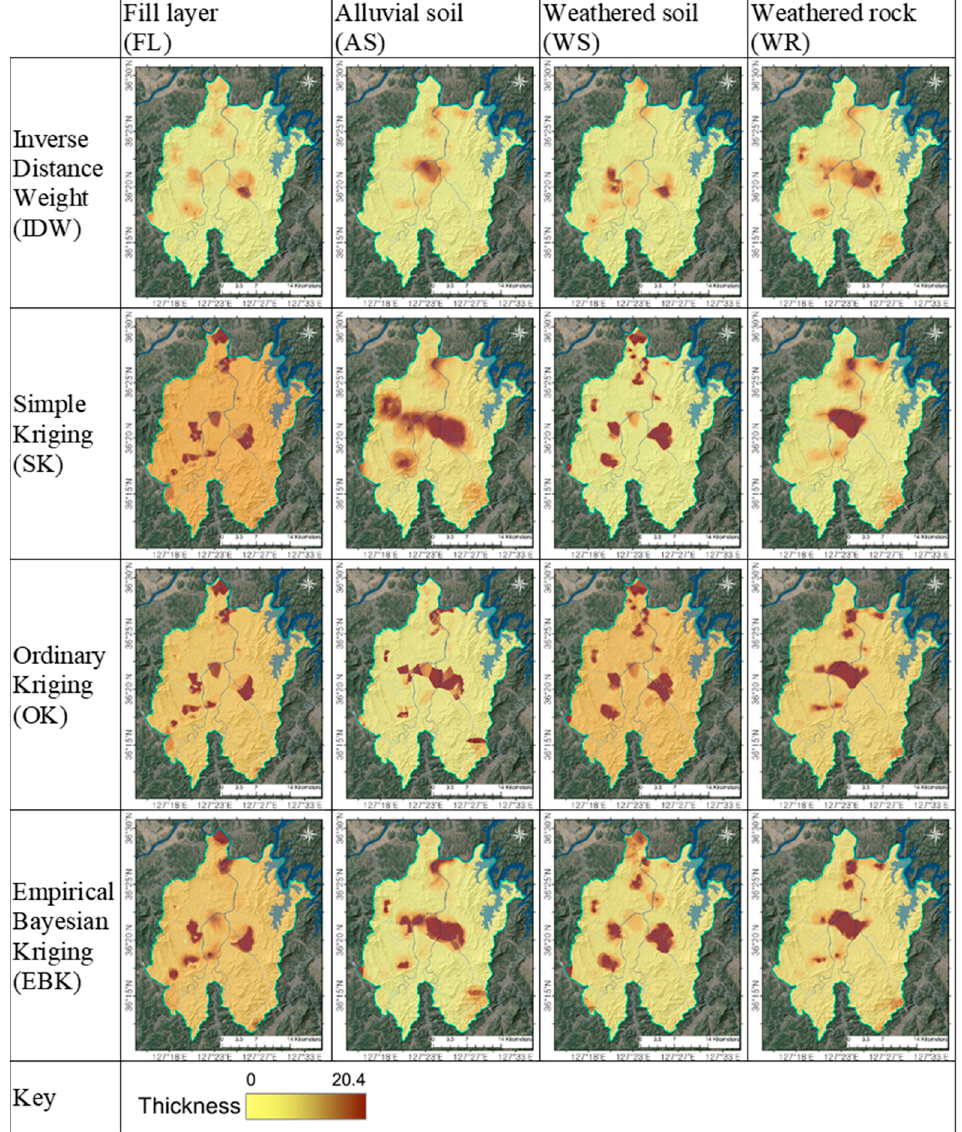
Figure 6. Comparison of geospatial maps of engineering geo-layer thickness between different geostatistical interpolation algorithms including: Inverse Distance Weighting; Simple Kriging; Ordinary Kriging; Empirical Bayesian Kriging.